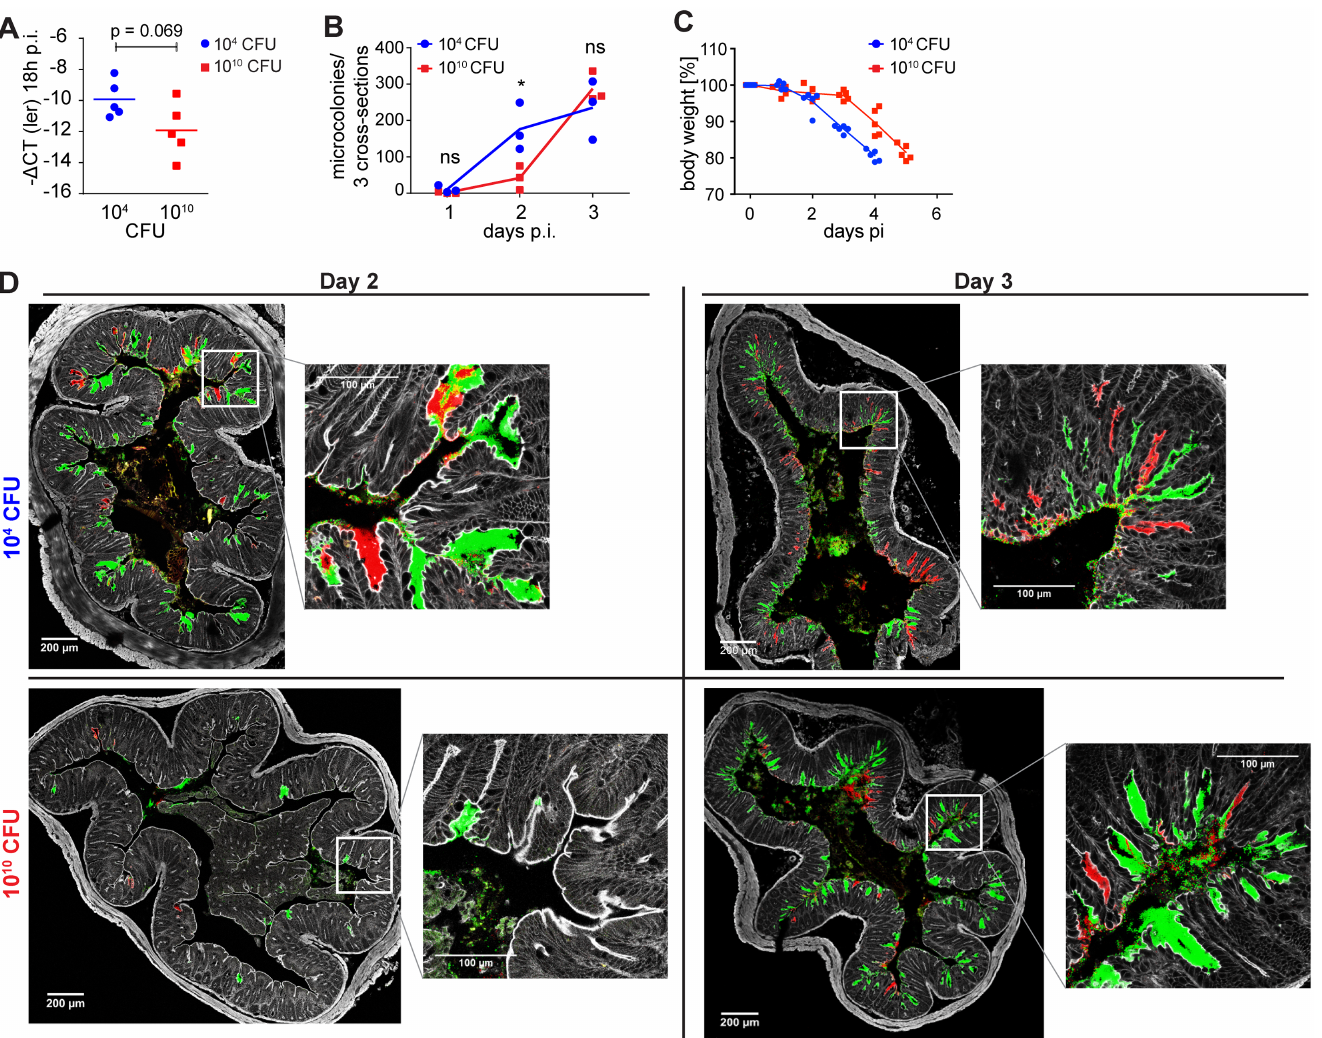
Fig 3. High-dose C . rodentium -infected MyD88/Trif-deficient mice do not display persistent disease attenuation. (A-C) Germ-free MyD88 -/- Trif lps/ lps mice were infected with either a low (10 4 CFU, blue dots) or a high dose (10 10 CFU, red squares) of wild type C . rodentium . ( A ) qPCR quantification of bacterial ler mRNA in colon content of infected MyD88 -/- Trif lps/lps germ-free mice at time point 18 h. Expression of ler was normalized to the mRNA encoding bacterialhousekeeping gene rpoD . ( B ) Microcolonies were quantitated in the distal colon after 1, 2, or 3 days of infection. (n = 3 per group, pooledfrom two independentexperiments). ( C ) Body weights of germ-free MyD88 -/- Trif lps/lps mice infected with either a low (10 4 CFU, blue circles) or a high dose (10 10 CFU, red squares) of wild type C . rodentium were monitored daily until reachingethicalendpoint.Symbolsrepresent individualmice. ( D ) Representative fluorescent microscopyimages of distal colon of germ-free MyD88 -/- Trif lps/lps mice after infectionwith doses of 10 4 or 10 10 CFU of C . rodentium for 2 days (left) and 3 days (right). Every individualdepictedwas infected with a 1:1 mixture of bacteria carryinga mCherry and GFP expression plasmid, respectively. Grey, F-actin/phalloidin;green, GFP-expressing C . rodentium ;red, mCherry-expressing C . rodentium . Scale bars: 200 μ m and 100 μ m as indicated. ns, statistically not significant; * , p < 0.05; Student‘s